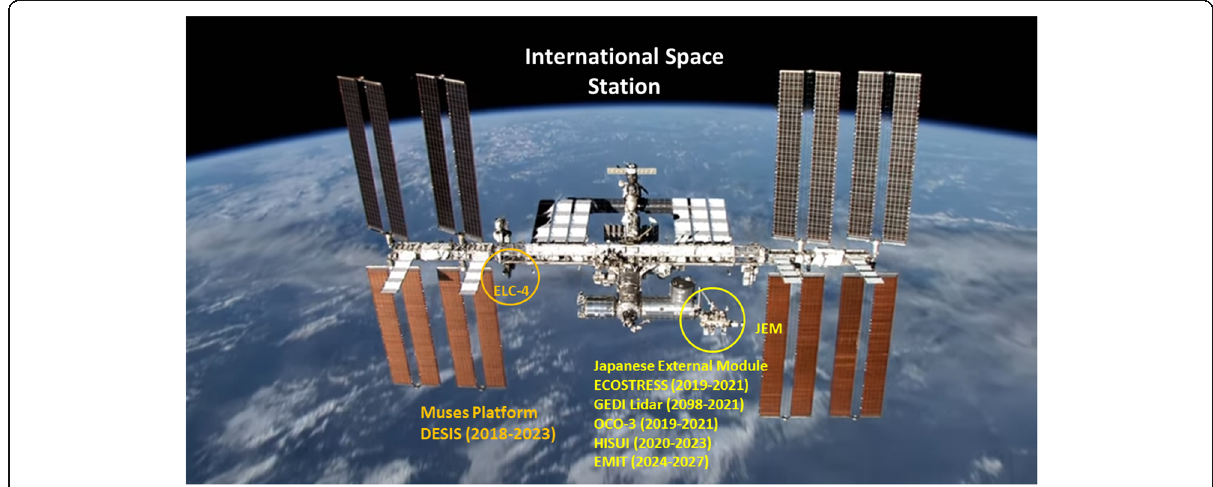
Fig. 17 The ISS observed on 21 February 2018 showing the positions on the Muses Platform where DESIS resides, and the Japanese External Module (JEM) where five new Earth observing instruments are located. Co-location allows synthesis of data from these sensors, whch has potential to significantly advance scientific understanding of earth system processes. Image courtesy of Michael Freilich, NASA